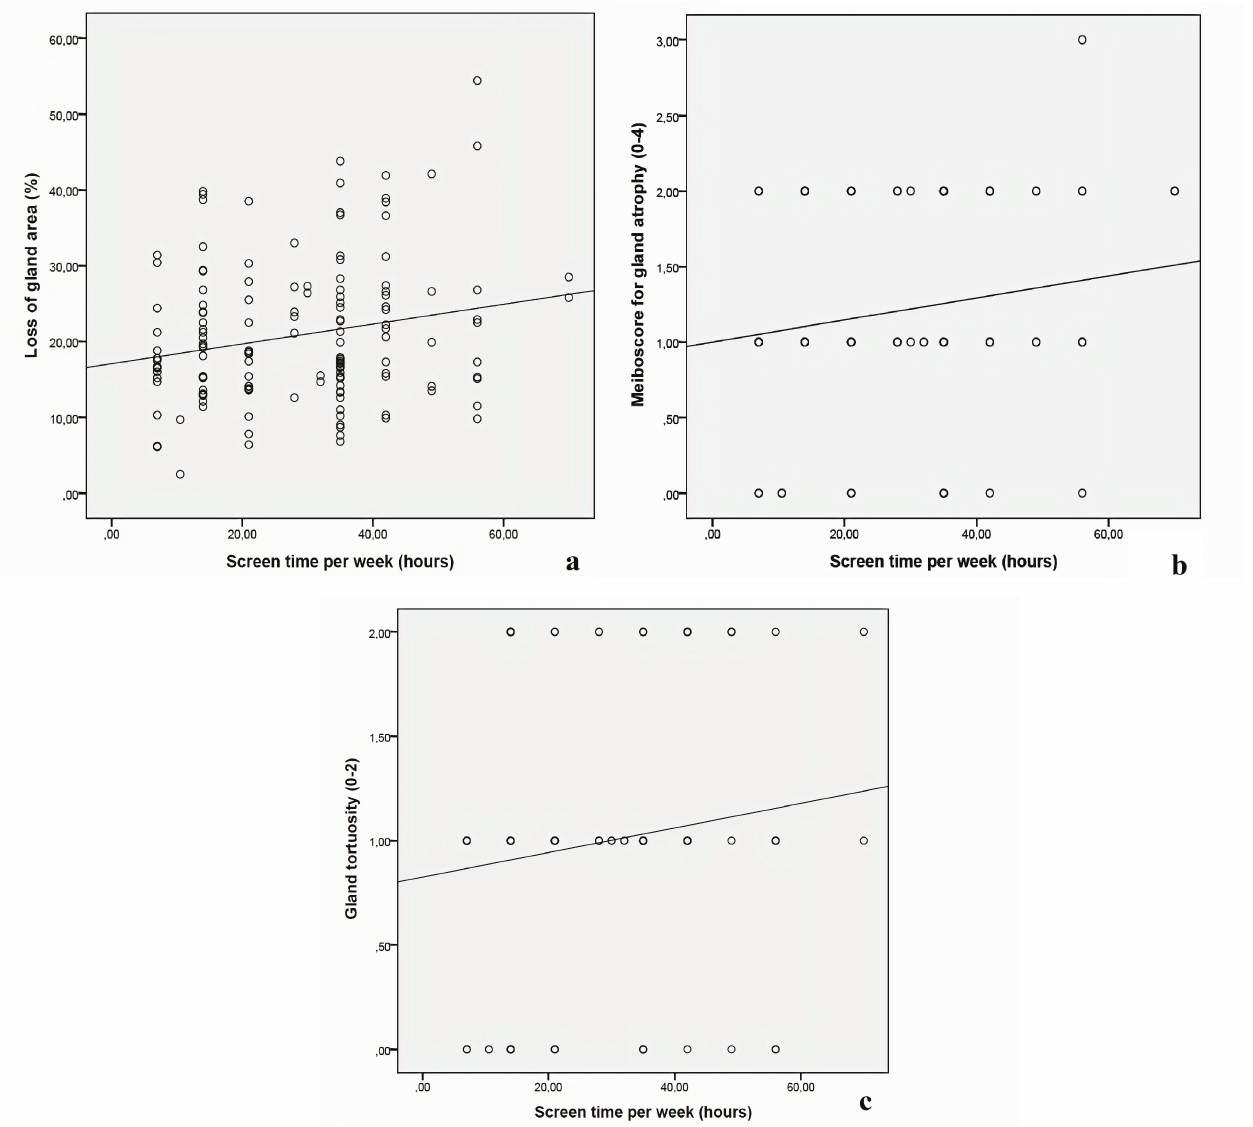
Figure 2. (a) Correlation graph of loss of meibomian gland area and screen time. (b) Correlation graph of meiboscale for gland atrophy and screen time. (c) Correlation graph of meibomian gland tortuosity and screen